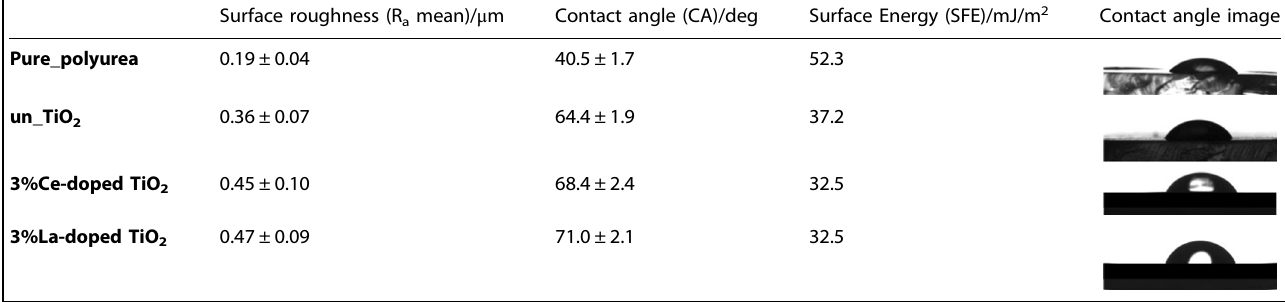
Table 2. Values (Mean ± SD) of Surface Roughness (Ra), Contact Angle (CA) and Surface Energy (SFE).